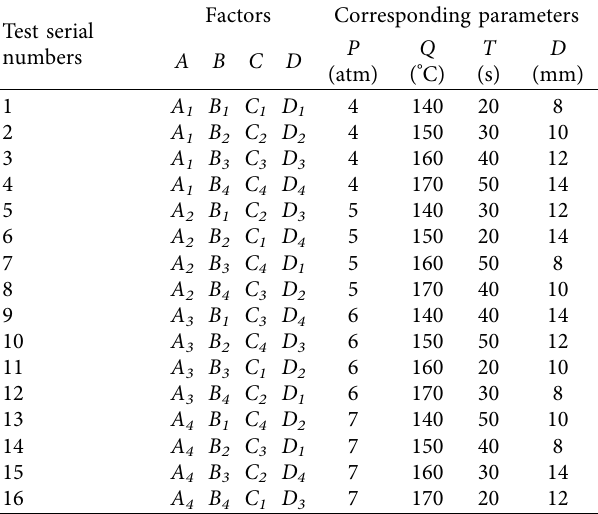
Table 2: Orthogonal test schemes.